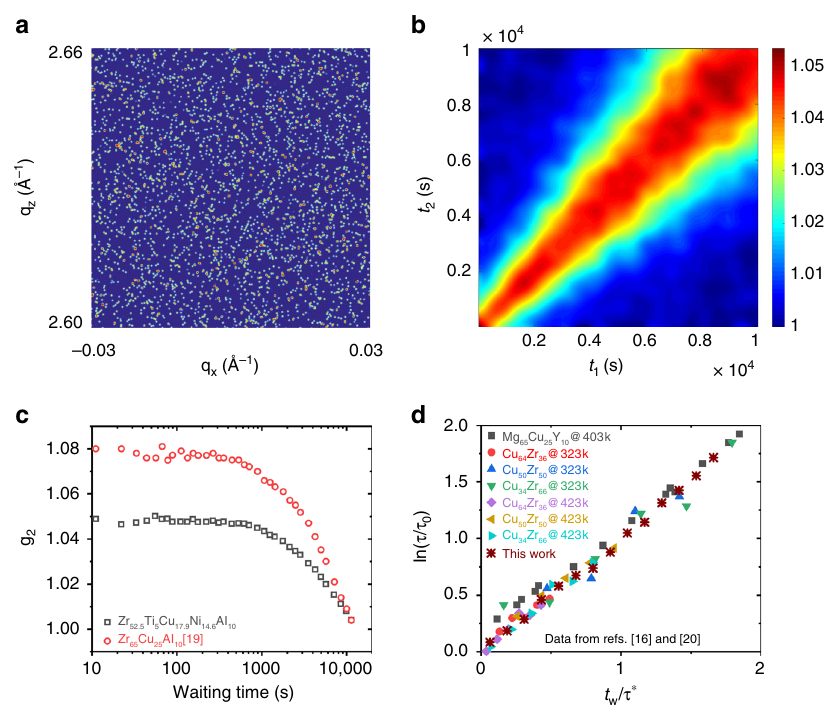
Fig. 2 Intensity autocorrelation functions and universal scaling. a An example of an experimental speckle pattern, b a two-time correlation function for the here-studied alloy obtained at room temperature and zero stress, c one-time correlation functions for two different Zr-based MGs measured at room temperature and zero stress, and d a rescaling of experimental data from ( b ) and refs. 16,20 , which demonstrates universal